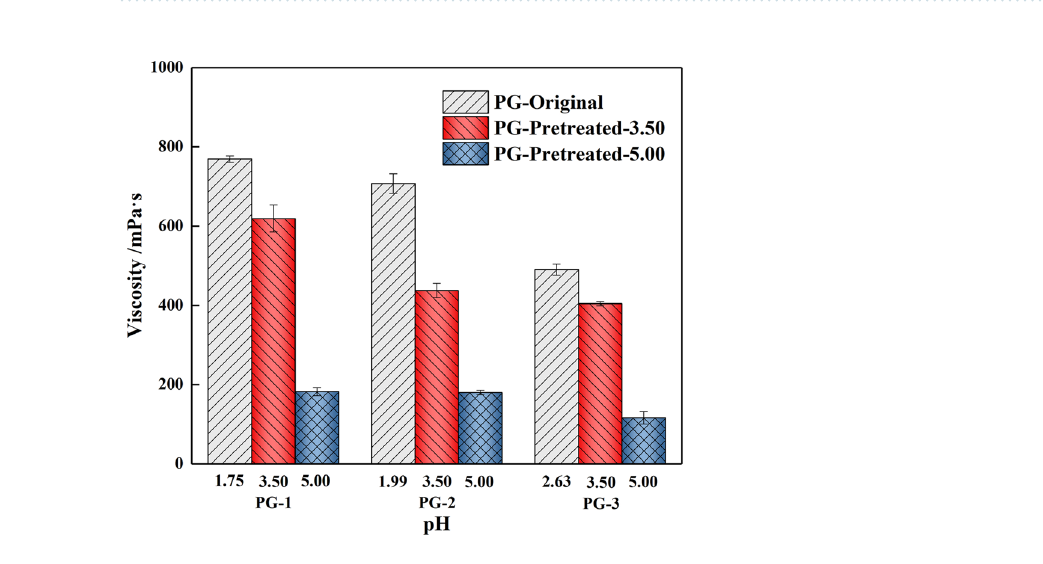
Figure 6. Variation of viscosity in backfill